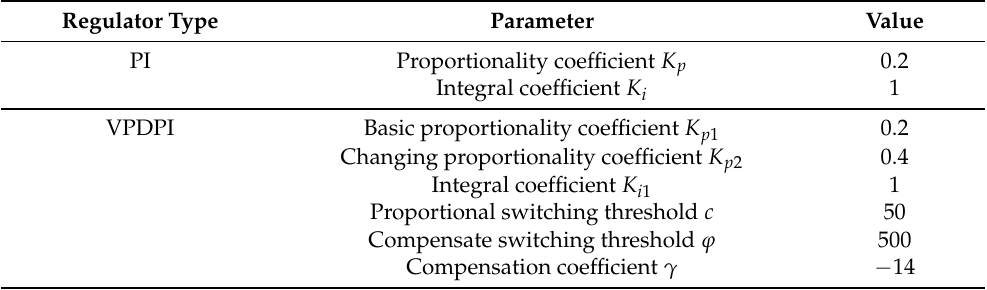
Table 3. The setting of regulators parameters.